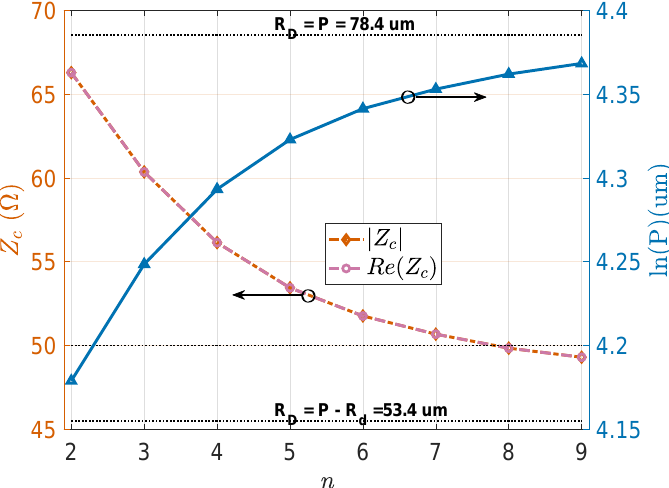
Figure 6. Simulation results of coaxial-like TSVs with different ground-TSV number, where the left axis is the characteristic impedance (its magnitude is completely overlapped with its real part) and the right axis is the TSV center distance in the natural logarithmic